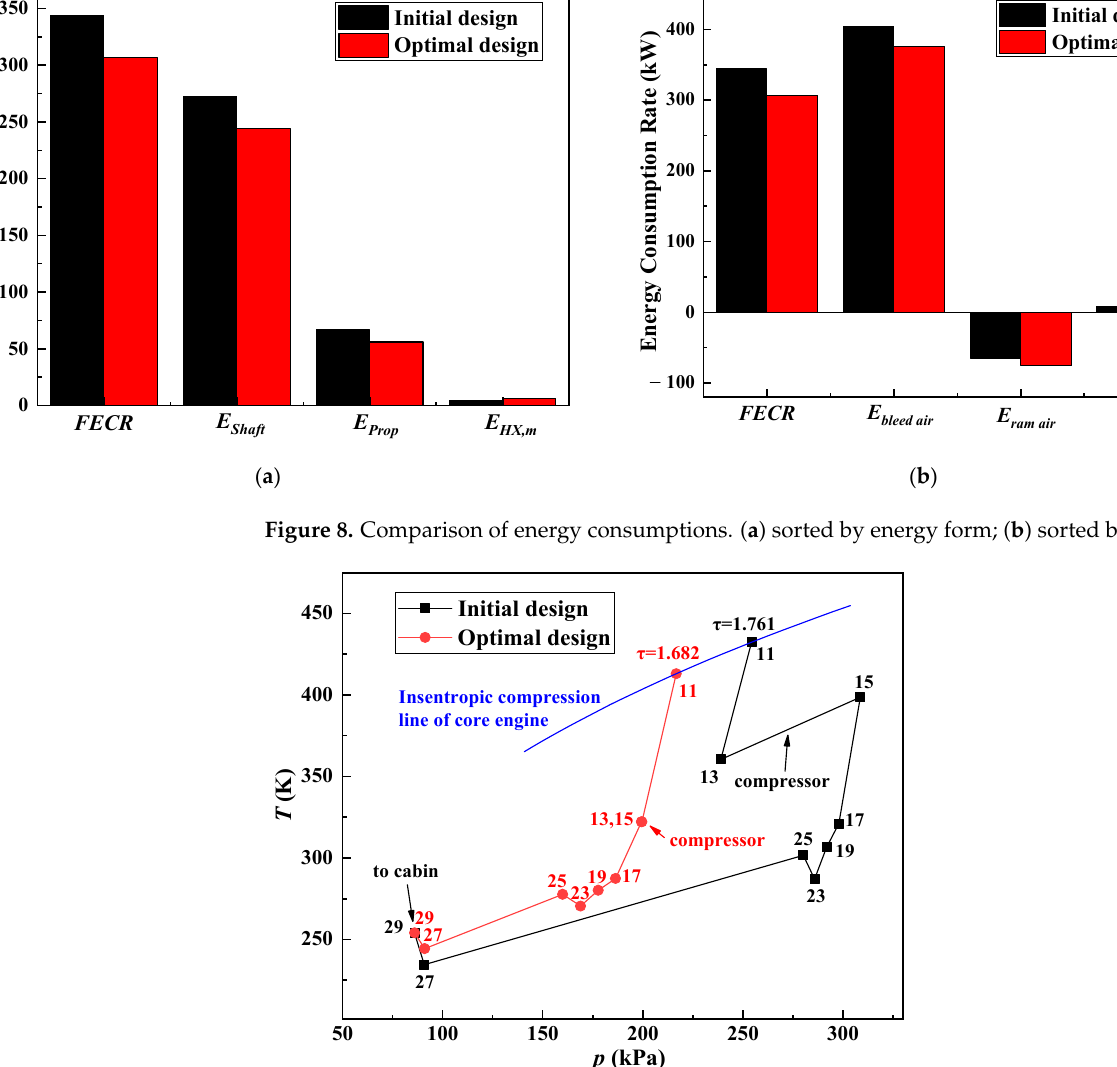
Figure 10. Enthalpy differences in ECS components. 4. Conclusions In this paper, the optimal design of the aircraft ECS is conducted by coupling the component-level models and the modified GA. To reach a better design of ECS with lower power consumption, several key design variables are optimized to obtain the system con- figuration of minimum FECR . The major conclusions are drawn as follows: (1) A novel evaluation method of energy utilization for ECS is proposed. The system output is set constant to avoid its unquantifiable characteristic with a thermo-economics criterion of FECR to evaluate the total energy consumption. In FECR , different forms of energy, including shaft power and propulsive power, are summed up with the weighting coefficient determined by the energy quality. (2) The continuity improvement implemented in the modified GA makes it have a better convergence. Compared with 29.3% of the optimized FECR lower than 308 kW by using standard GA, the modified GA increases such share to 47.6%, and the growth rate is up to 62.4%. This modification on the algorithm improves the efficiency of energy-sav- ing optimization of such energy systems such as ECS.